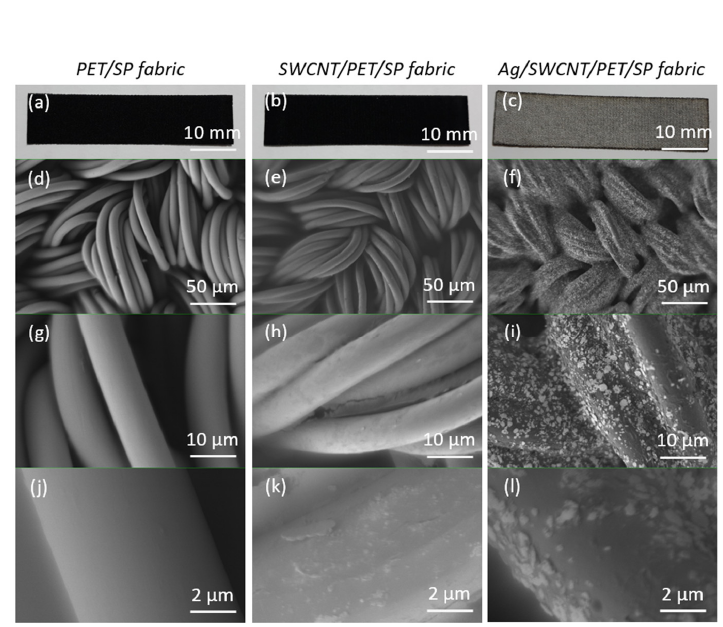
Figure 2. SEM pictures of the sensors at di ff erent magnifications consisting of ( a ) initial PET / SP fabrics at 10 mm, ( b ) SWCNT sensors at 10 mm, ( c ) Ag / SWCNT sensors at 10 mm, ( d ) PET / SP fabrics at 50 µ m, ( e ) SWCNT sensors at 50 µ m, ( f ) Ag / SWCNT sensors at 50 µ m, ( g ) PET / SP fabrics at 10 µ m, ( h ) SWCNT sensors at 10 µ m, ( i ) Ag / SWCNT sensors at 10 µ m, ( j ) PET / SP fabrics at 2 µ m, ( k ) SWCNT sensors at 2 µ m, ( l ) Ag / SWCNT sensors at 2 µ